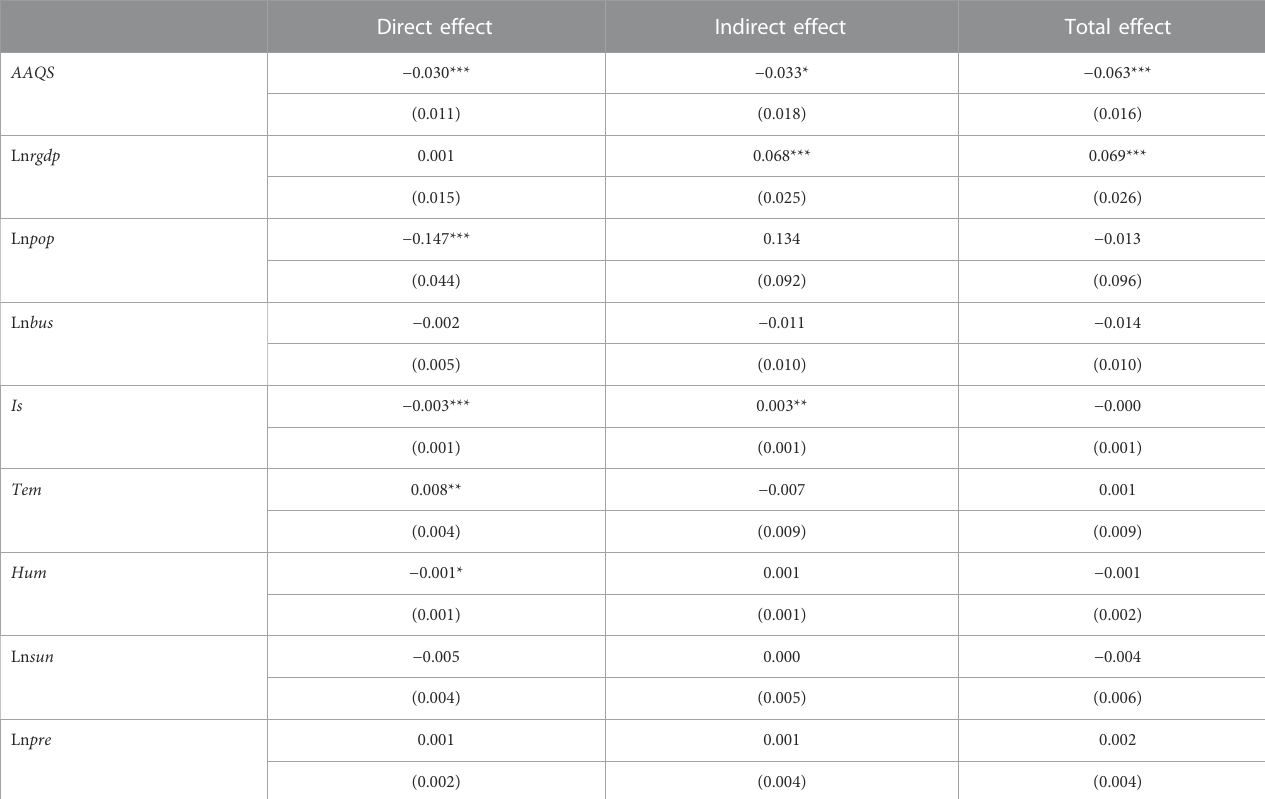
TABLE 4 Direct, indirect, and total effects of SDM in Table 3.